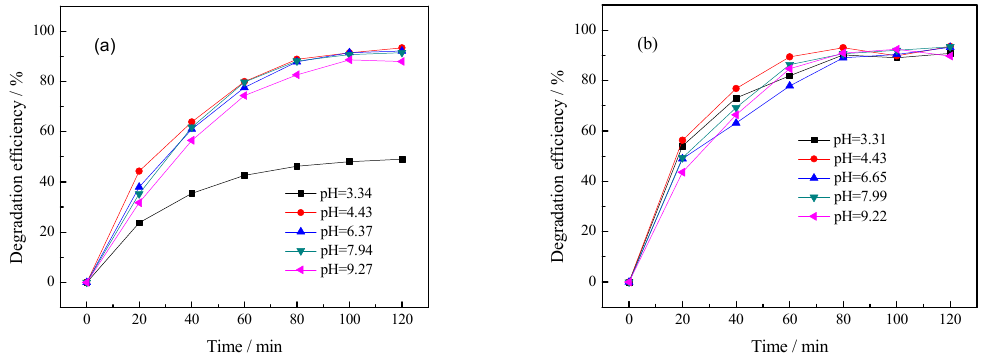
Figure 9. Effect of initial pH value on photocatalytic degradation of benzohydroxamic acid: ( a ) the pH value was adjusted by HNO 3 and NaOH; ( b ) the pH value was adjusted by HCl and NaOH). Reaction conditions: C (benzohydroxamic acid) = 30 mg·L − 1 , C (catalyst dosage) = 0.5 g·L − 1 , 300 W mercury lamp, 0.75% La/TiO 2 , calcined temperature at 500 °C.